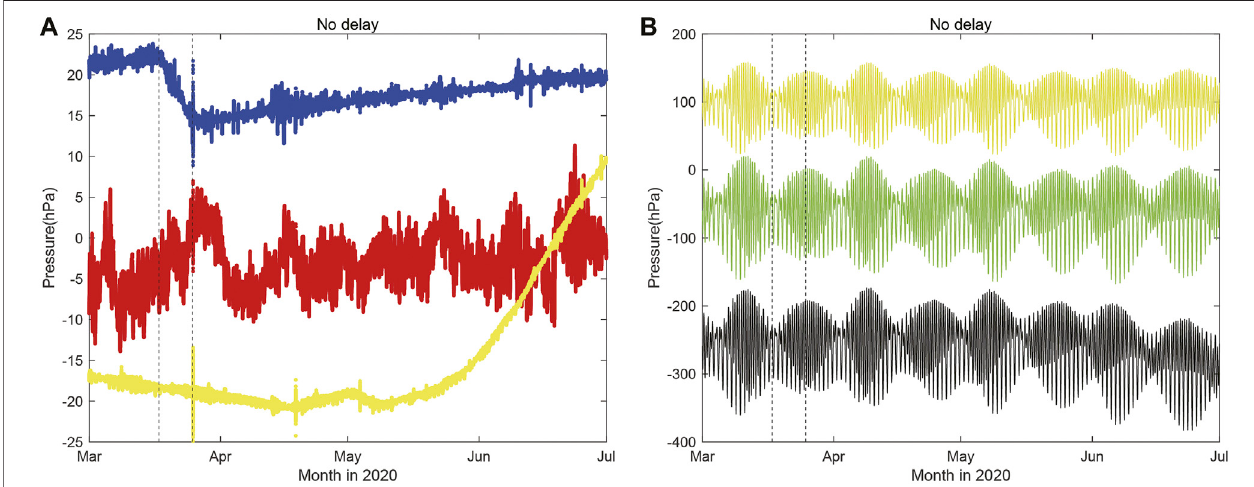
FIGURE 2 | Time history of the pore pressure (compression: positive) (A) at the deepest sensors (Pc1) of each borehole observatory (C0002 blue; C0010 red; C0006yellow), (B) rawdataofPc1(yellow),Pc0(black)atC0006andKMC11(green).Theoceanicsignalsarecanceledoutbythereferencehydraulicpressuregaugeon thesea fl oorwithouttimedelayaccordingto Eq.1 .Theverticallinesrepresenttheonset/terminationtimeoftheSSE.Offsetvalueforeachstationisarbitraryandadjusted to see easily.